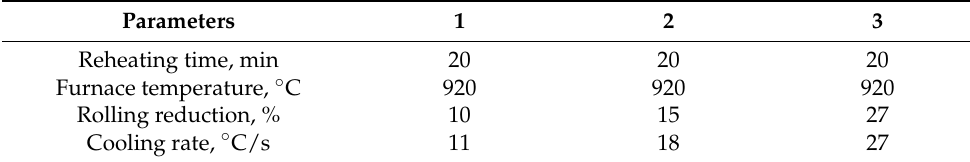
Figure 1. The heat treatment and rolling experiment process. Each steel plate was heated to a single austenitizing temperature of 920 ◦ C, and then at different cooling rates to obtain the structure; the room temperature structure was ferrite and pearlite phase. The cooling rates were 11, 18, 27 ◦ C/s, and the reduction rates were set to 10%, 15%, and 27%. Table 2 shows the rolling process and experimental parameters. Table 2. Hot rolling experimental parameters for oxidation